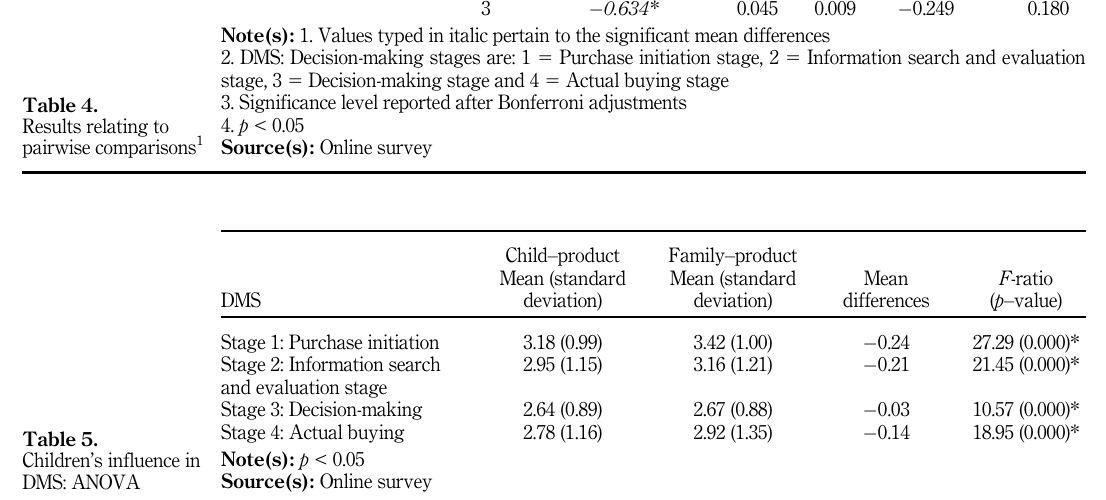
Table 5. Children ’ s influence